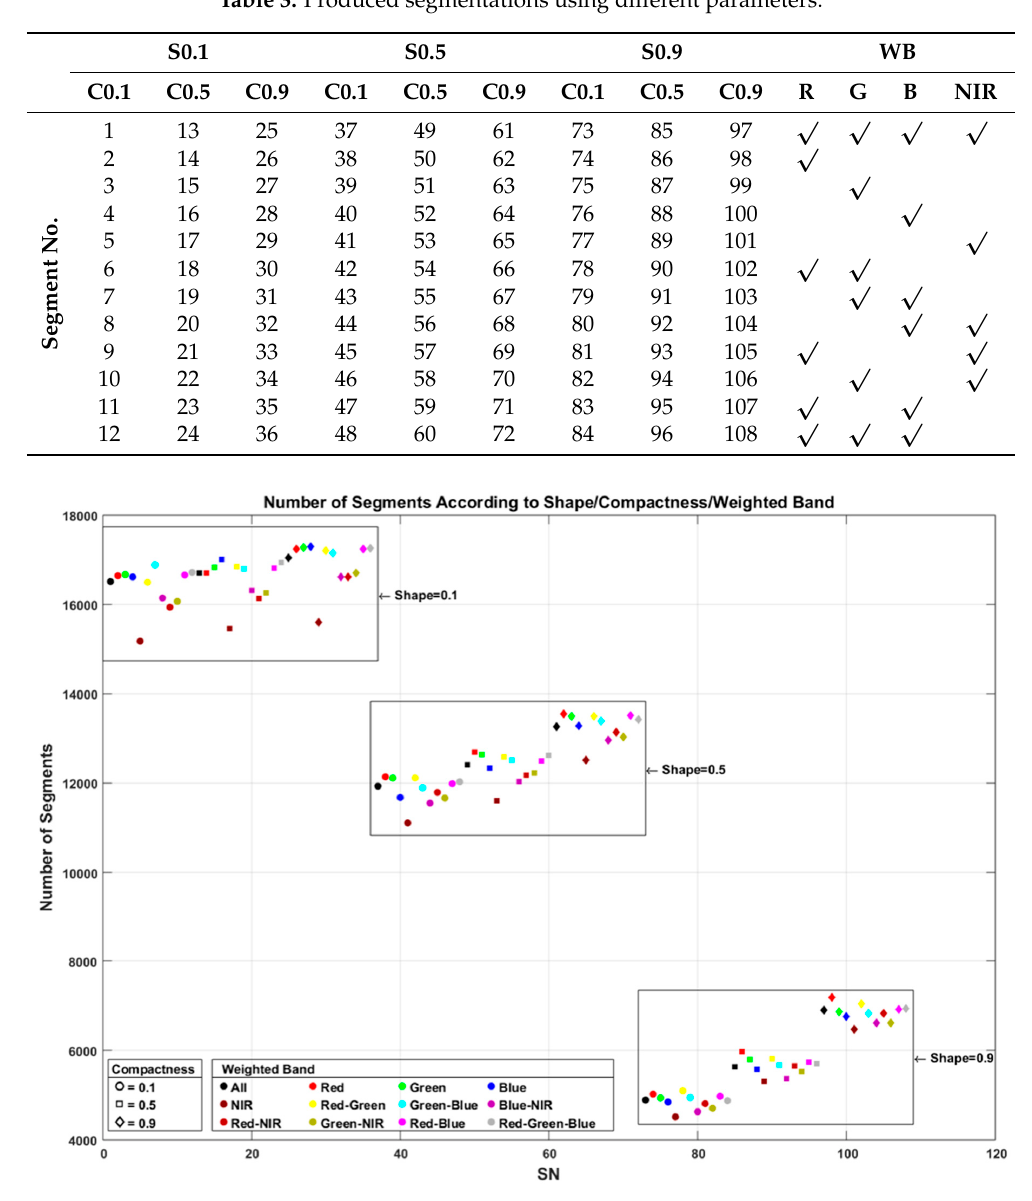
Figure 4. Number of segments according to segmentation parameters.